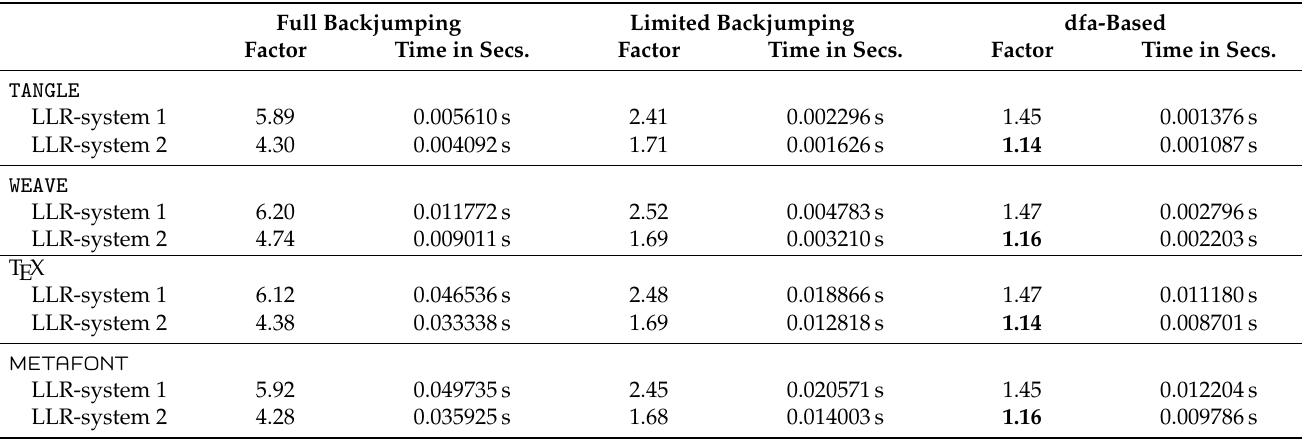
Table 5. Parsing of TANGLE , WEAVE , TEX and METAFONT using two different LLR-systems: running times of parsing and scanning in seconds and comparison to the bison -generated parser. Full Backjumping Limited Backjumping dfa-Based Factor Time in Secs. Time in